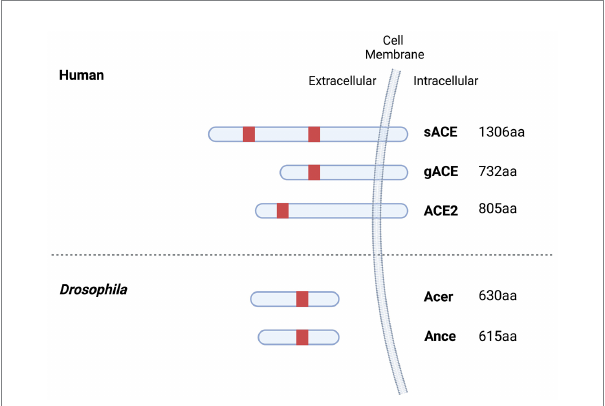
FIGURE 2 ACE family members in humans and Drosophila . Ance and Acer are homologous to ACE and share 61% (45% identity, 48% coverage) and 58% (41% identify, 45% coverage) amino acid similarity with ACE. Active site domains containing the conserved catalytic consensus zinc-binding motif (HEXXH) are indicated in red. sACE possess two active protein domains (N- and C- domain) whereas gACE, ACE2, Ance and Acer only have one. gACE is identical to that of the C domain of sACE except for its first 36 residues. Human ACE and ACE2 are integral-membrane proteins whereas Drosophila Ance and Acer lack a transmembrane domain. (Created with BioRender.com).